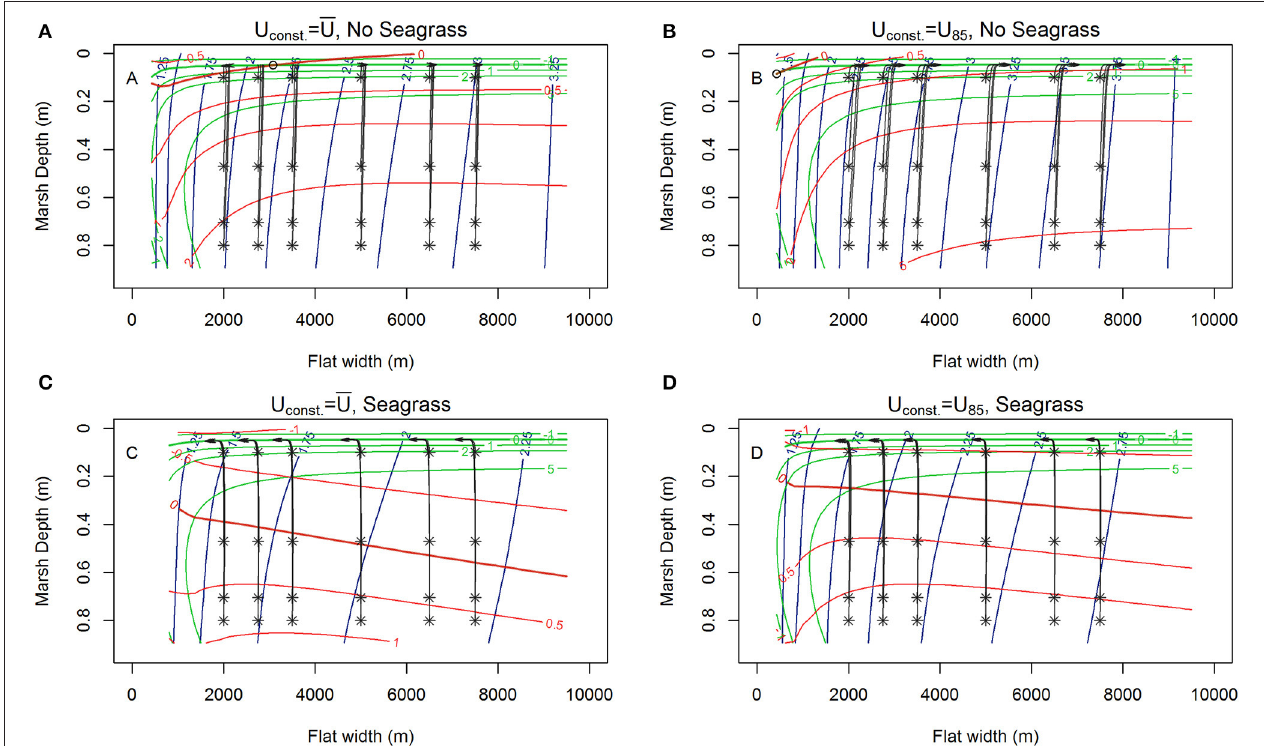
FIGURE 5 | Contours of lateral rates of change in tidal flat width (red), and vertical changes in marsh depth (green) from MHW alongside 1,000 year trajectories (black) of the system initiated at various tidal flat widths and marsh depths along the tidal flat depth nullcline surface (blue contours) for various wind conditions, RSLR = 4mm year − 1 , Co = 50 mg/L. (A) Unstable equilibria (open circle) with erosion or progradation depending on flat width., no seagrass, marshes maintaining pace with RSLR ( U const = U = 6.87m s − 1 ). (B) Shift of unstable equilibria (hollow circle) to vary narrow flat widths, no seagrass, marshes maintaining pace with RSLR (U 85 = 8.5m s − 1 ). (C) Shift to prograding system in the presence of seagrass, marshes maintaining pace with RSLR ( U const = U = 6.87m s − 1 , N = 250 shoots m − 2 ). (D) Shift to progradation in the presence of seagrass, but slower progradation rate due to higher winds, with marshes maintaining pace with RSLR (U 85 = 8.5m s − 1 , N = 250 shoots m − 2 ).